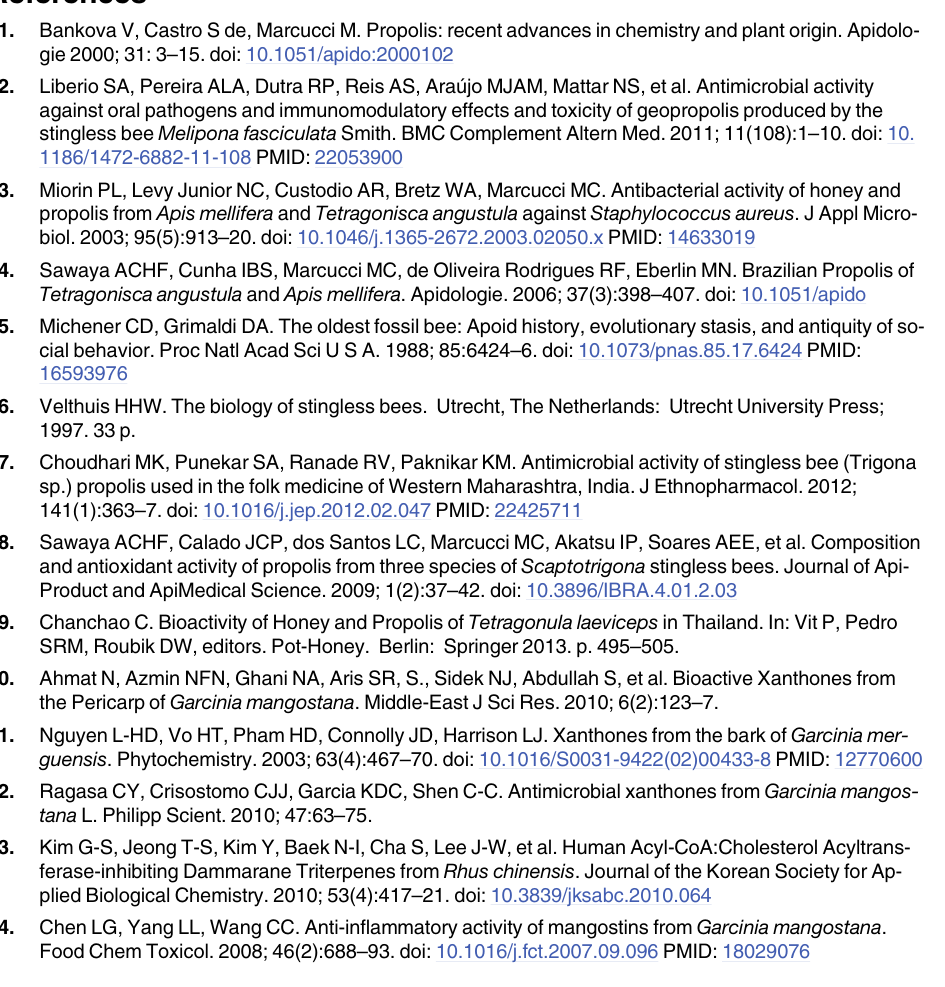
S16 Fig. Mass spectra of silylated maslinic and corosolic acids (from GC-MS of sample T . melanoleuca ). S17 Fig. Mass spectra of silylated 2,3-dihydroxyoleanadien-28-oic and 2,3-dihydroxyursa- dien-28-oic acids (from GC-MS of sample T . melanoleuca